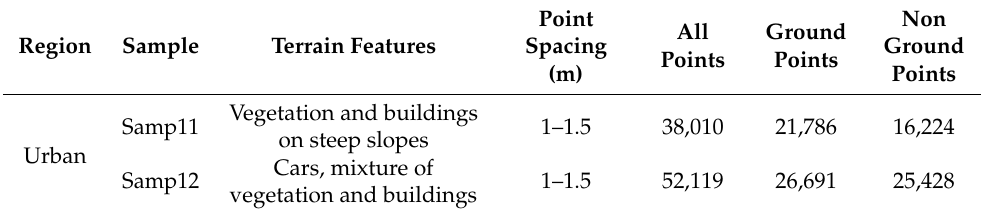
Table 1. Characteristics of each sample in the